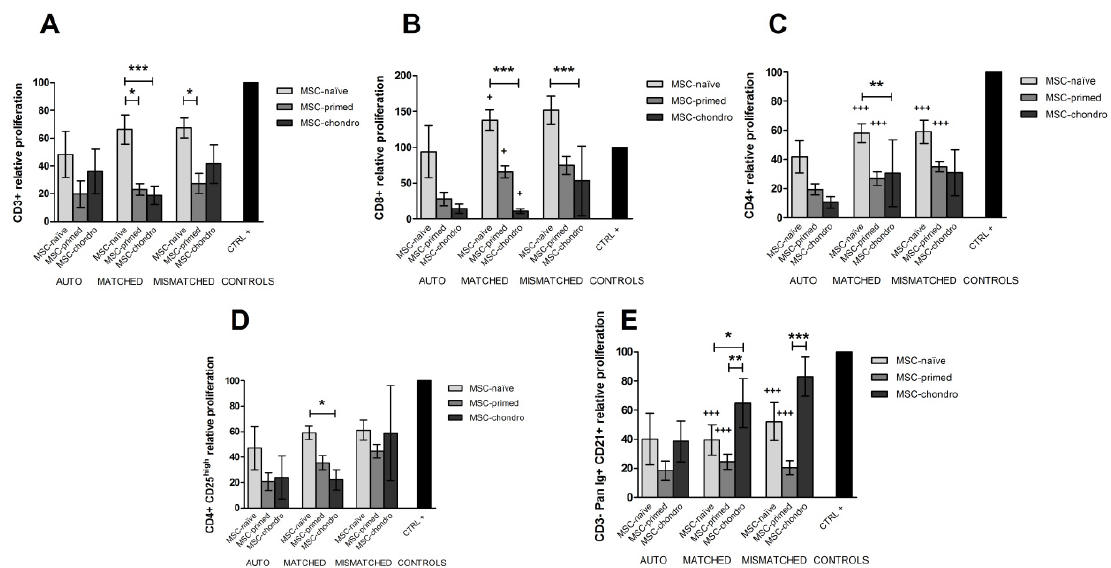
Figure 4. Mean ± SEM of the relative proliferation of different lymphocyte subsets in the immunomodulatory assays: ( A ) CD3+ T lymphocytes, ( B ) CD8+ cytotoxic T cells, ( C ) CD4+ helper T cells, ( D ) CD4+ CD25 high regulatory T cells, ( E ) CD3 − Pan-Ig+ CD21+ B cells. Phytohemagglutinin (PHA)-activated PBLs were exposed in vitro to MSC-naïve (light grey bar), MSC-primed (medium grey bar) and MSC-chondro (dark grey bar). Co-cultures of MSCs and PBLs were autologous ( n = 3) or allogeneic, matched ( n = 8) or mismatched ( n = 7) for the MHC. Data from each PBL donor is normalised over the positive control (CTRL+) consisting of PHA-stimulated PBLs alone from the same donor (100%, maximum proliferation) to account for inter-individual variability. Significant differences of each condition over the CTRL+ (black bar) are represented by a cross (+) above the corresponding bar (+ = p < 0.05; +++ = p < 0.001). Significant differences between experimental conditions are represented by a squared line with an asterisk (* = p < 0.05; ** = p < 0.01; *** = p <